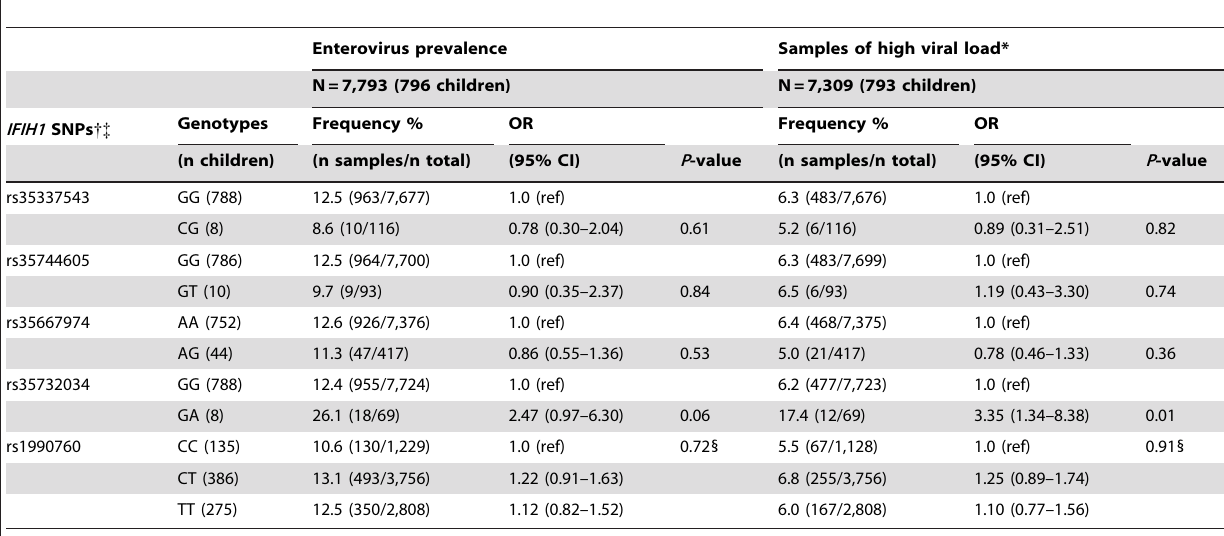
Table 1. Prevalence (%) of enterovirus RNA in fecal samples and frequency of positive samples with a high viral load according to IFIH1